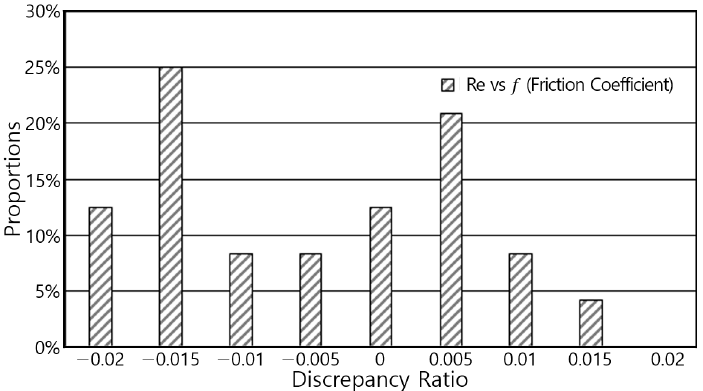
Figure 10. The discrepancy ratio for (cid:1858) and (cid:1844)(cid:1857) calculated using Babaeyan-Koopaei’s data.